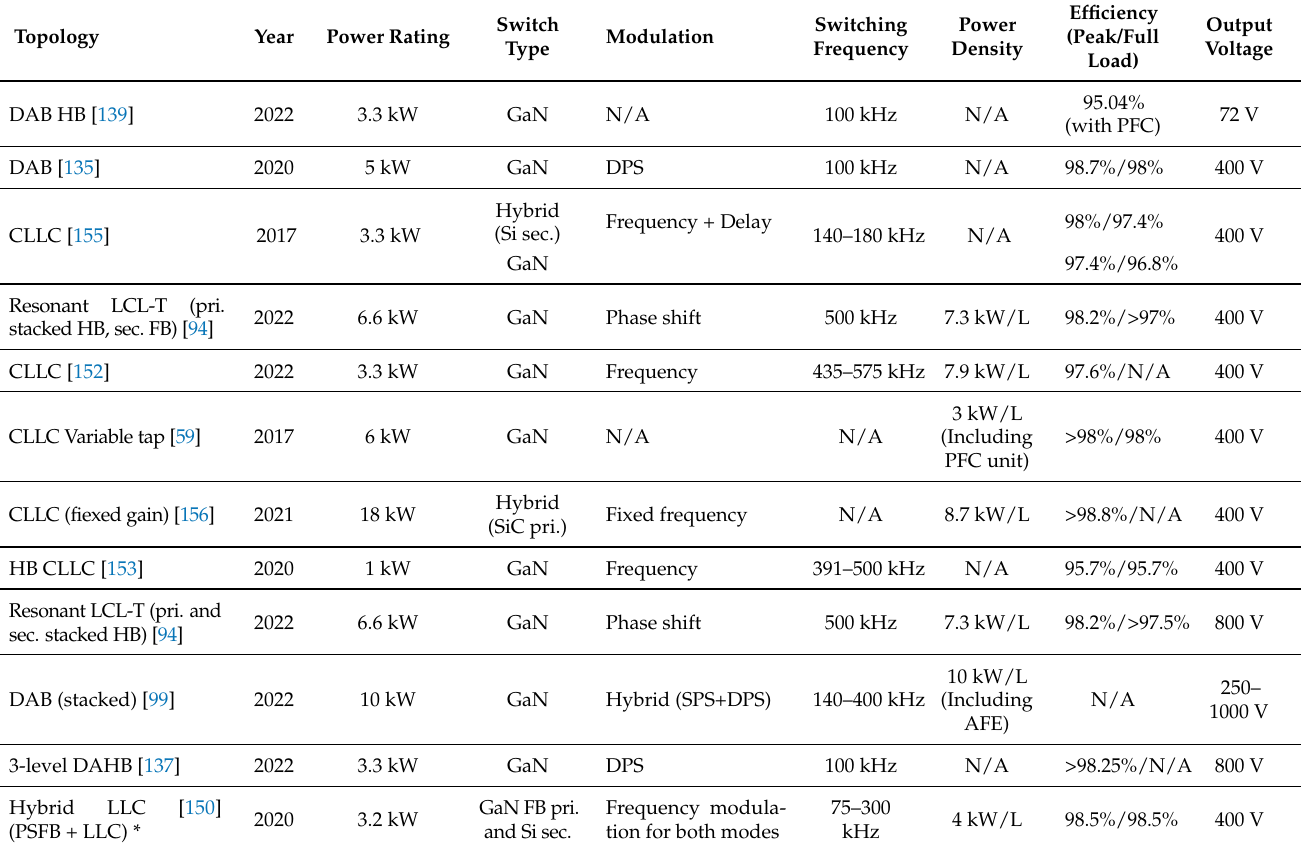
Table 10. SummaryofGaN-basedisolatedDC/DCconvertertopologiesfor400Vand800